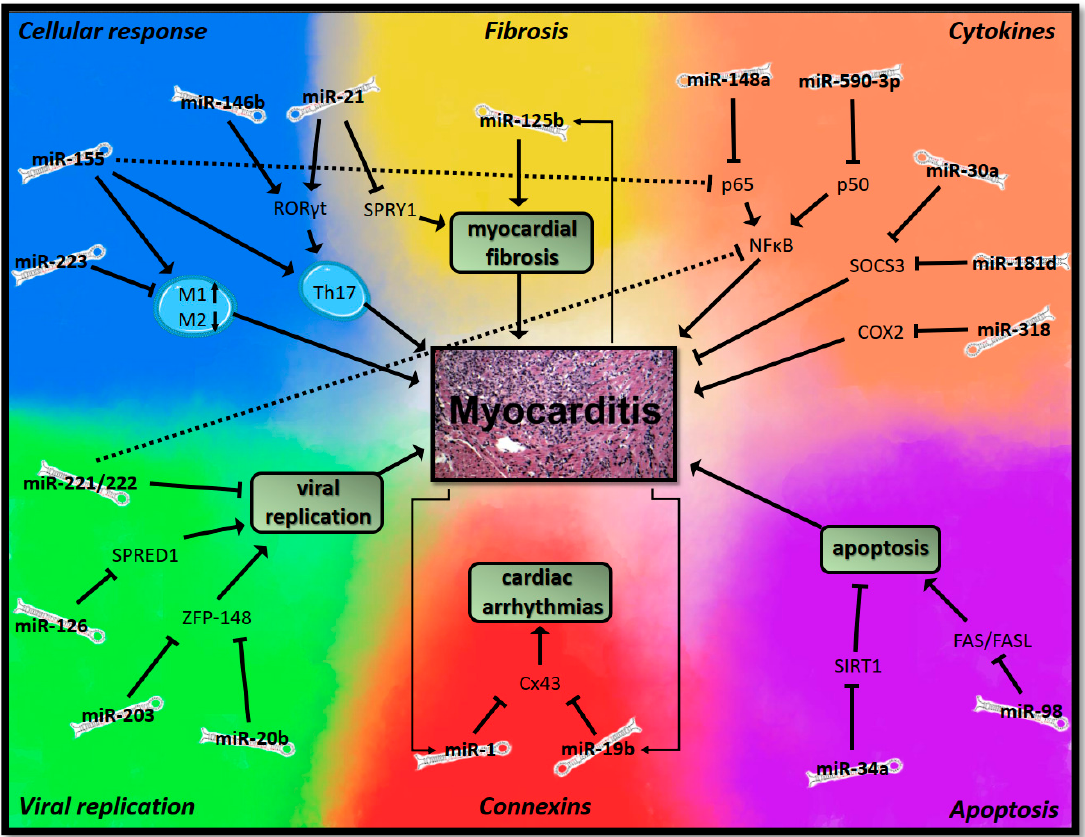
Figure 1. Schematic presentation of the putative mechanisms of the microRNAs (miRNAs) involved in myocarditis.